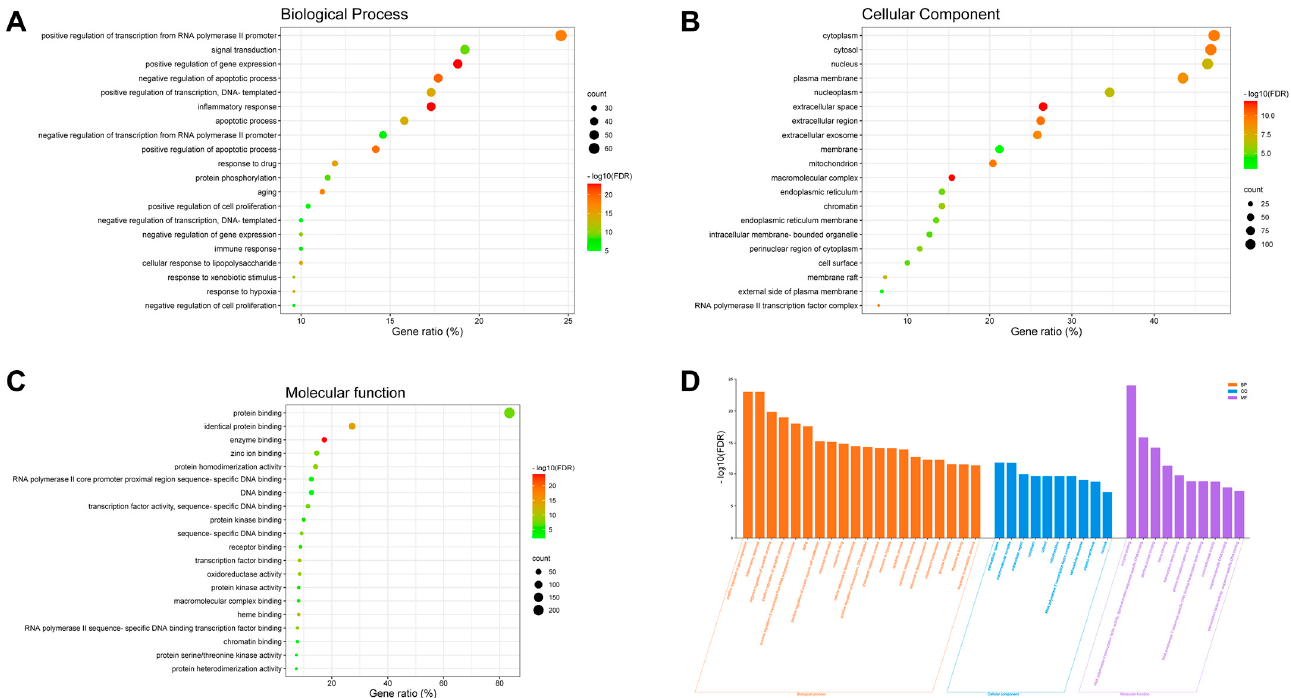
Figure 2. Gene Ontology (GO) enrichment analysis of Aloe vera –non-alcoholic-steatohepatitis (NASH) common targets. Bubble charts of top 20 GO terms based on gene ratio in the categories of ( A ) biological process, ( B ) cellular component, and ( C ) molecular function. The X -axis and Y -axis show gene ratios (%) and GO terms, respectively; the color and size of each bubble represent false discovery rate (FDR) values and gene count, respectively. ( D ) Top GO terms by FDR values. BP, biological process; CC, cellular component; MF, molecular function.